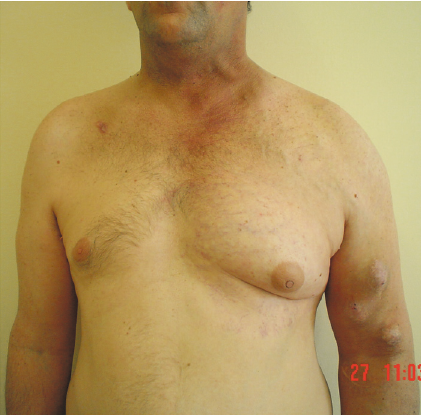
Figure 1: Swelling of the left upper arm and left chest wall. Right subclavian scar.